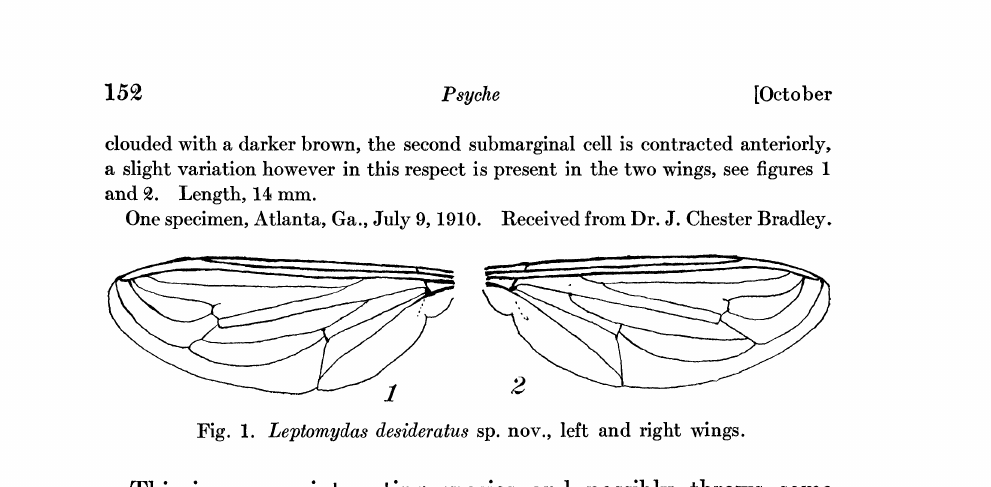
Fig. 1. Leptomydas desideratus sp. nov., left and right